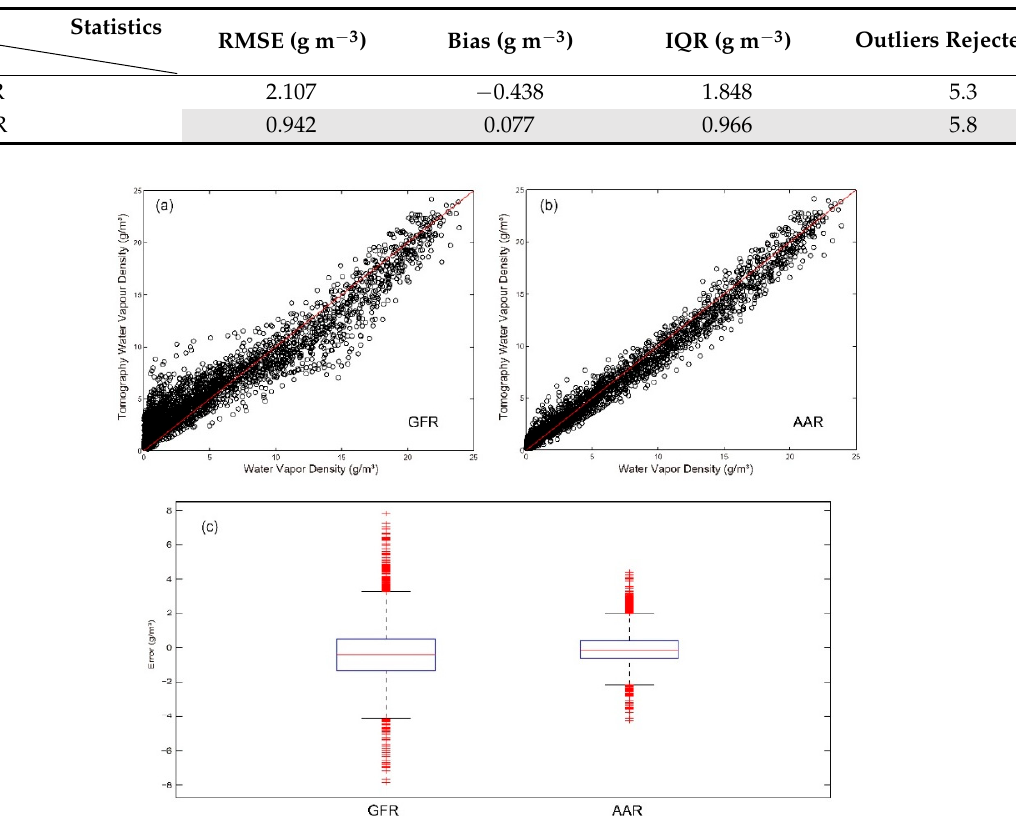
Table 3. Statistics show the difference in water vapor estimations between GFR and AAR throughout